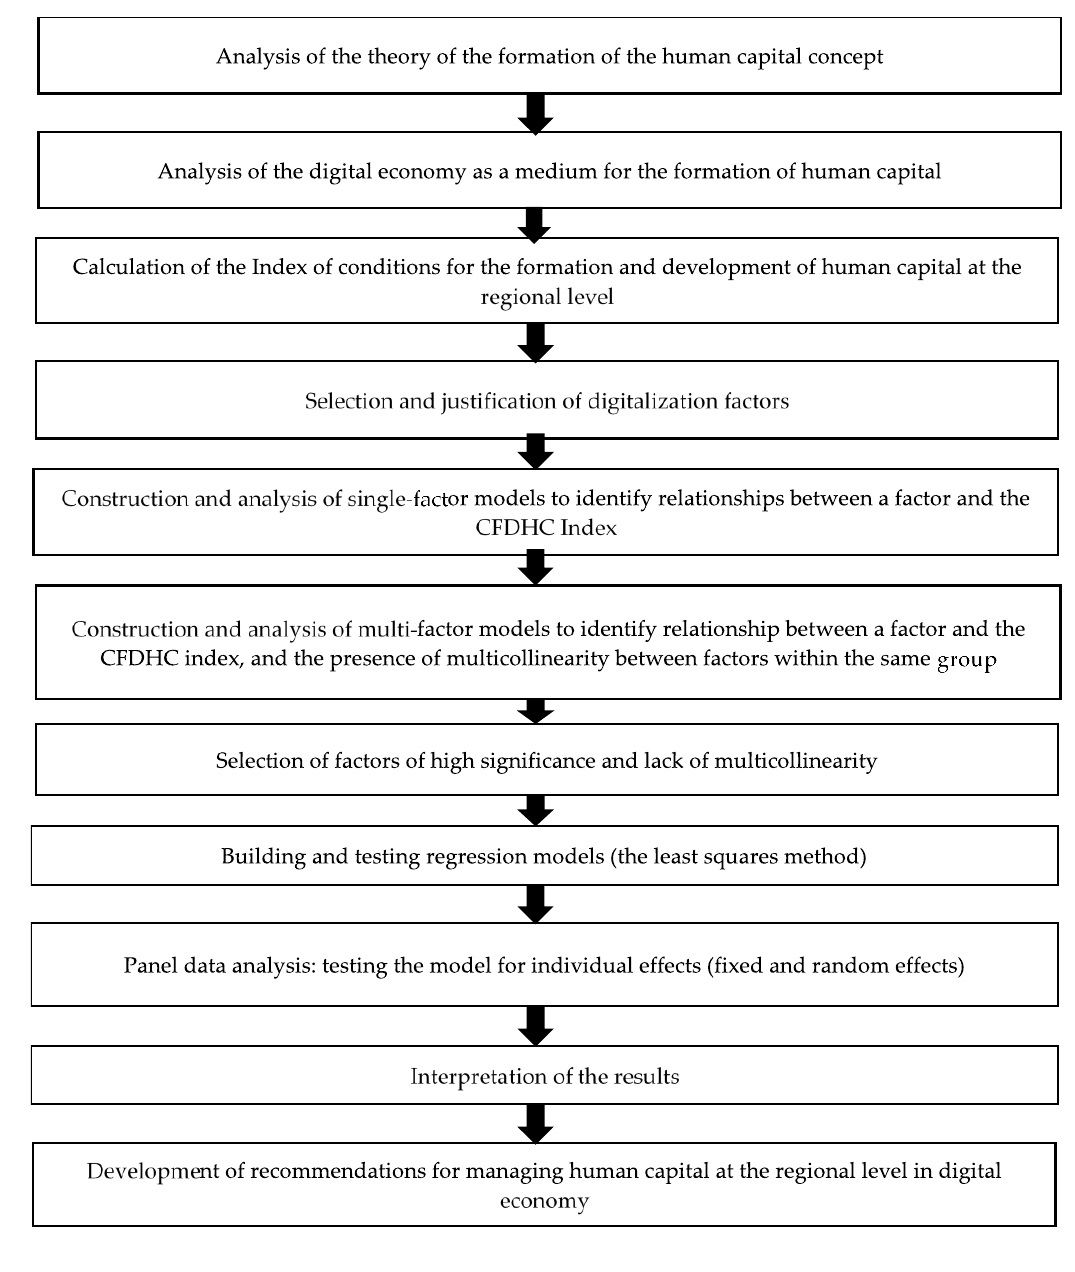
Figure 1. Research algorithm.